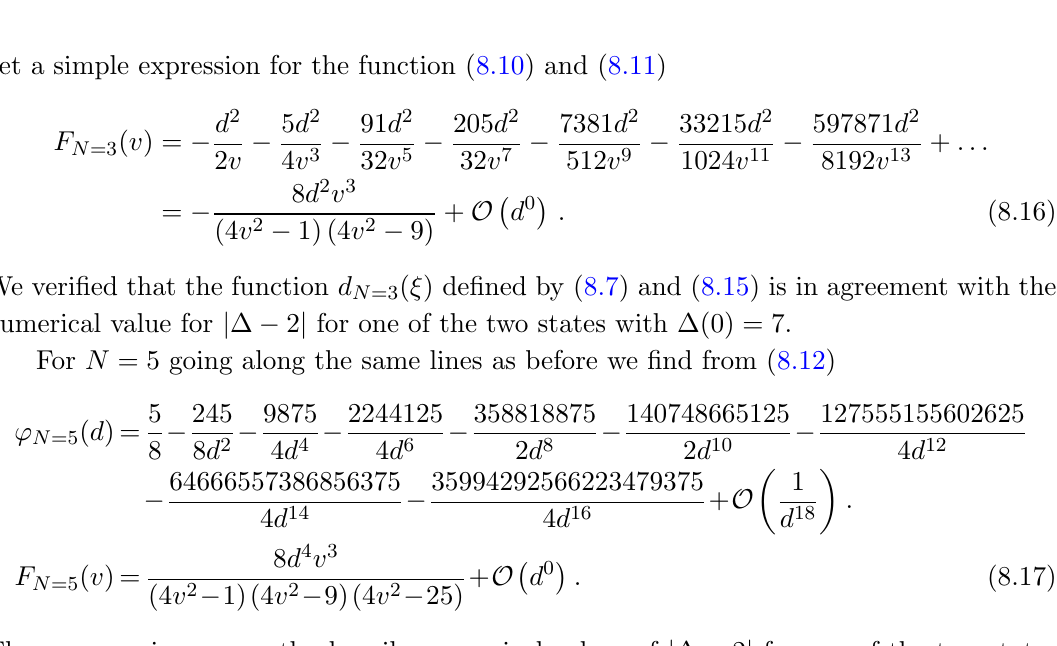
Figure 11 . Comparison of the numerical values for (cid:6)j (cid:1) (cid:0) 2 j (solid green line) for the state with (cid:1)(0) = 3 with the large (cid:24) expansion (8.7) and (8.13) (dotted black line). The lines almost coincide for up to very small values of (cid:24)